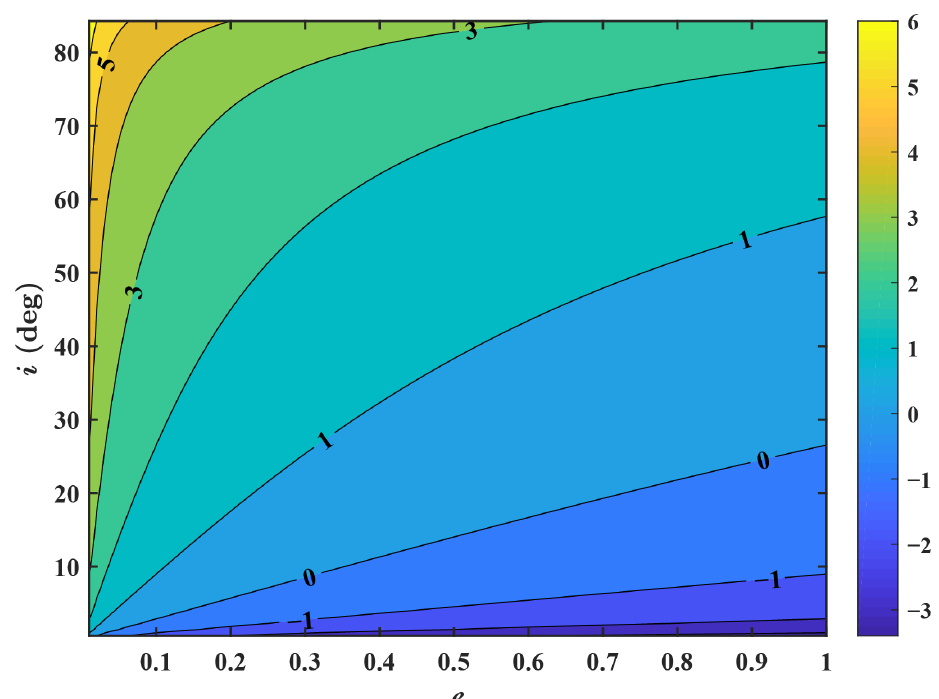
Figure 3. Value of parameter log